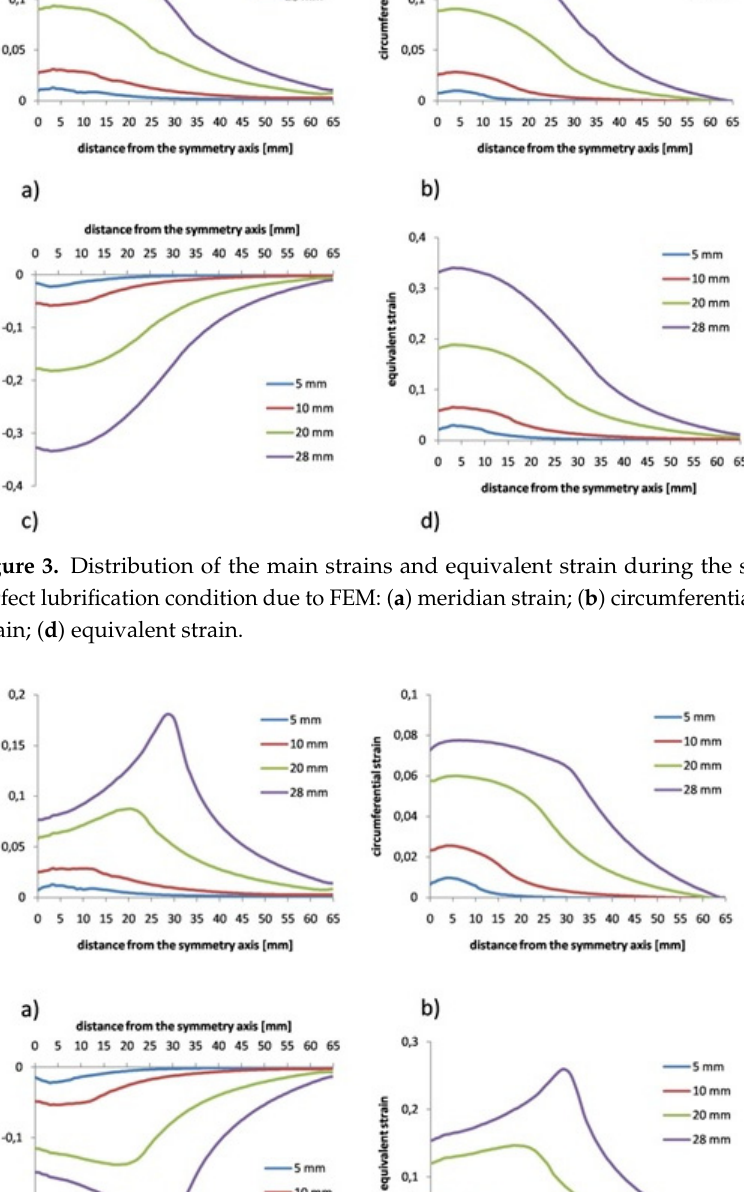
Figure 5. Distribution of the main strains and equivalent strain during the stretching process in friction conditions with a friction coefficient μ = 0.2 due to FEM: ( a ) meridian strain; ( b ) circumferential strain; ( c ) thickness strain; ( d ) equivalent strain. The axisymmetric stretching process was simulated by FEM too using sheets with a variable initial thickness as shown in Figure 1. The proposed thickness profile provided a reduction of the thickness towards the edge of the sheet, that is, in correspondence of that